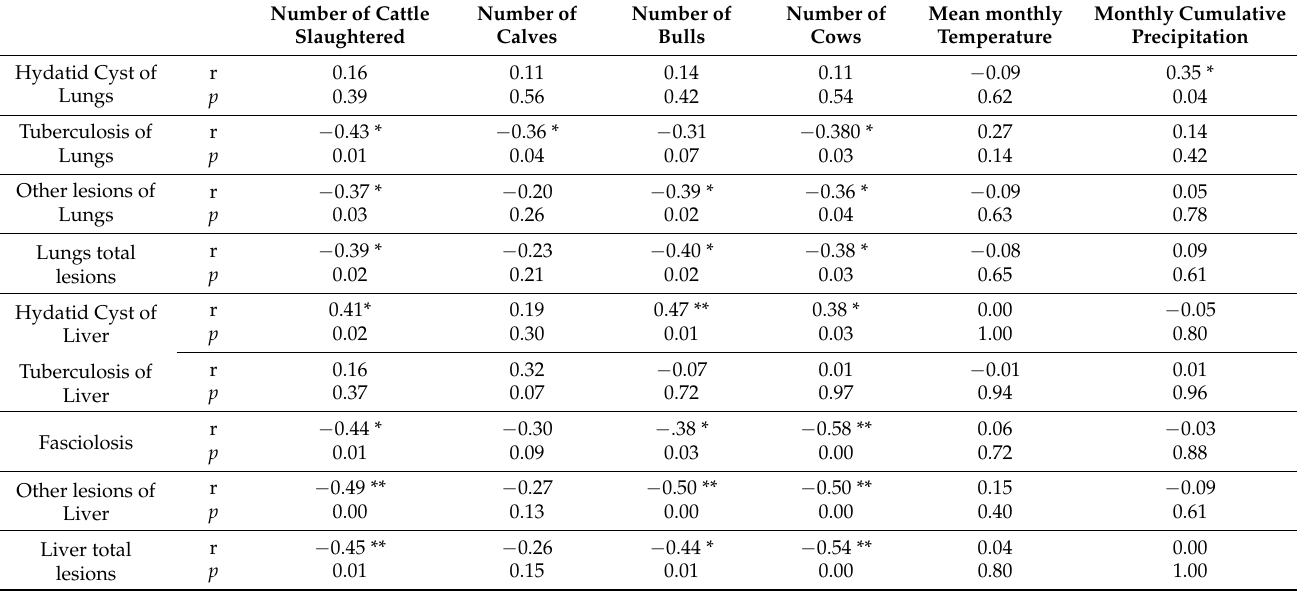
Table 5. Pearson correlation of liver and lung lesions with continuous variables. Number of Cattle Number of Number of Number of Mean monthly Slaughtered Calves Bulls Cows